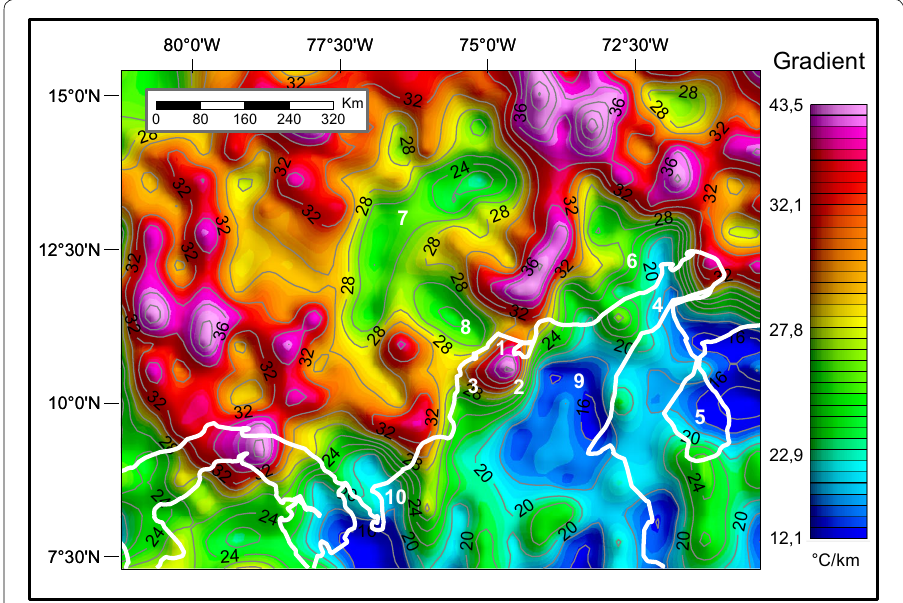
Fig. 6 Colombian‑Caribbean Geothermal Gradient Map. White line indicates the littoral and border lines of Colombia Venezuela and Panama. The extreme values of the color bar result from the interpolation, 1: Barranquilla; 2: Sabanagrande; 3: Cartagena; 4: Guajira; 5: Gulf of Maracaibo; 6: Offshore Guajira Basin; 7: Colombia Basin; 8: Magdalena Delta; 9: Plato Sub‑Basin (in the Lower Magdalena Valley); 10: Uraba